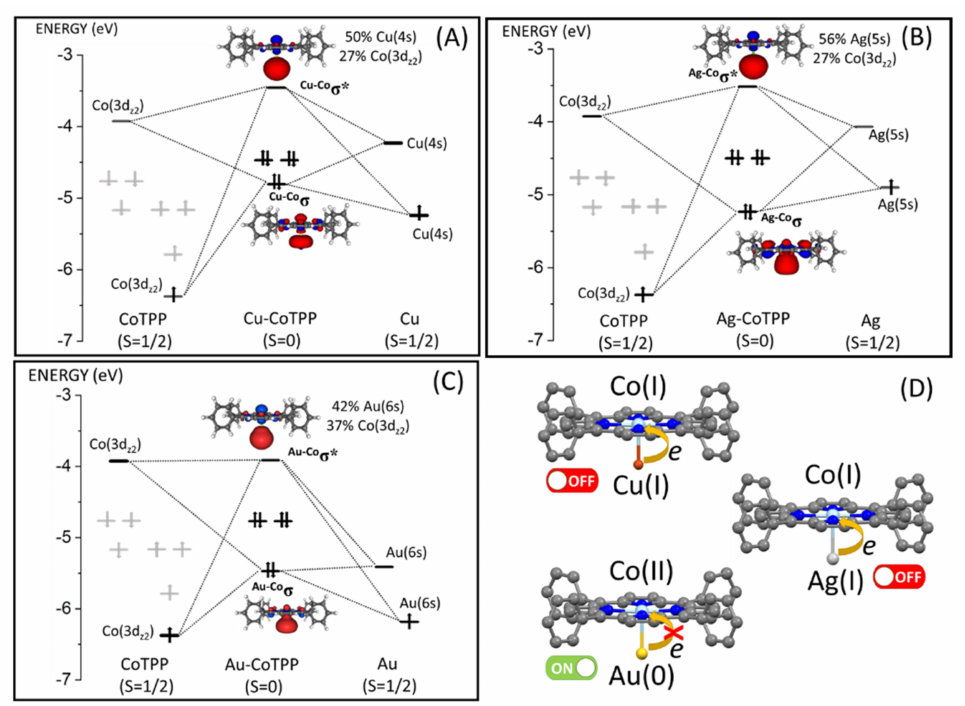
Figure 1. Correlation diagrams between CoTPP frontier energy levels and the ( n + 1)s MS AO of ( A ) Cu–CoTPP ( n = 3), ( B ) Ag–CoTPP ( n = 4), and ( C ) Au–CoTPP ( n = 5) C 4v clusters. The 3D plots of the in-phase and out-of-phase combinations between the Co 3d z 2-based MO and the MS ( n + 1)s AO are also displayed (isosurfaces correspond to ± 0.03 e 1/2 × A − 3/2 ). ( D ) Sketch of the different charge transfer behaviour along the triad. Colour codes are the same adopted in Scheme